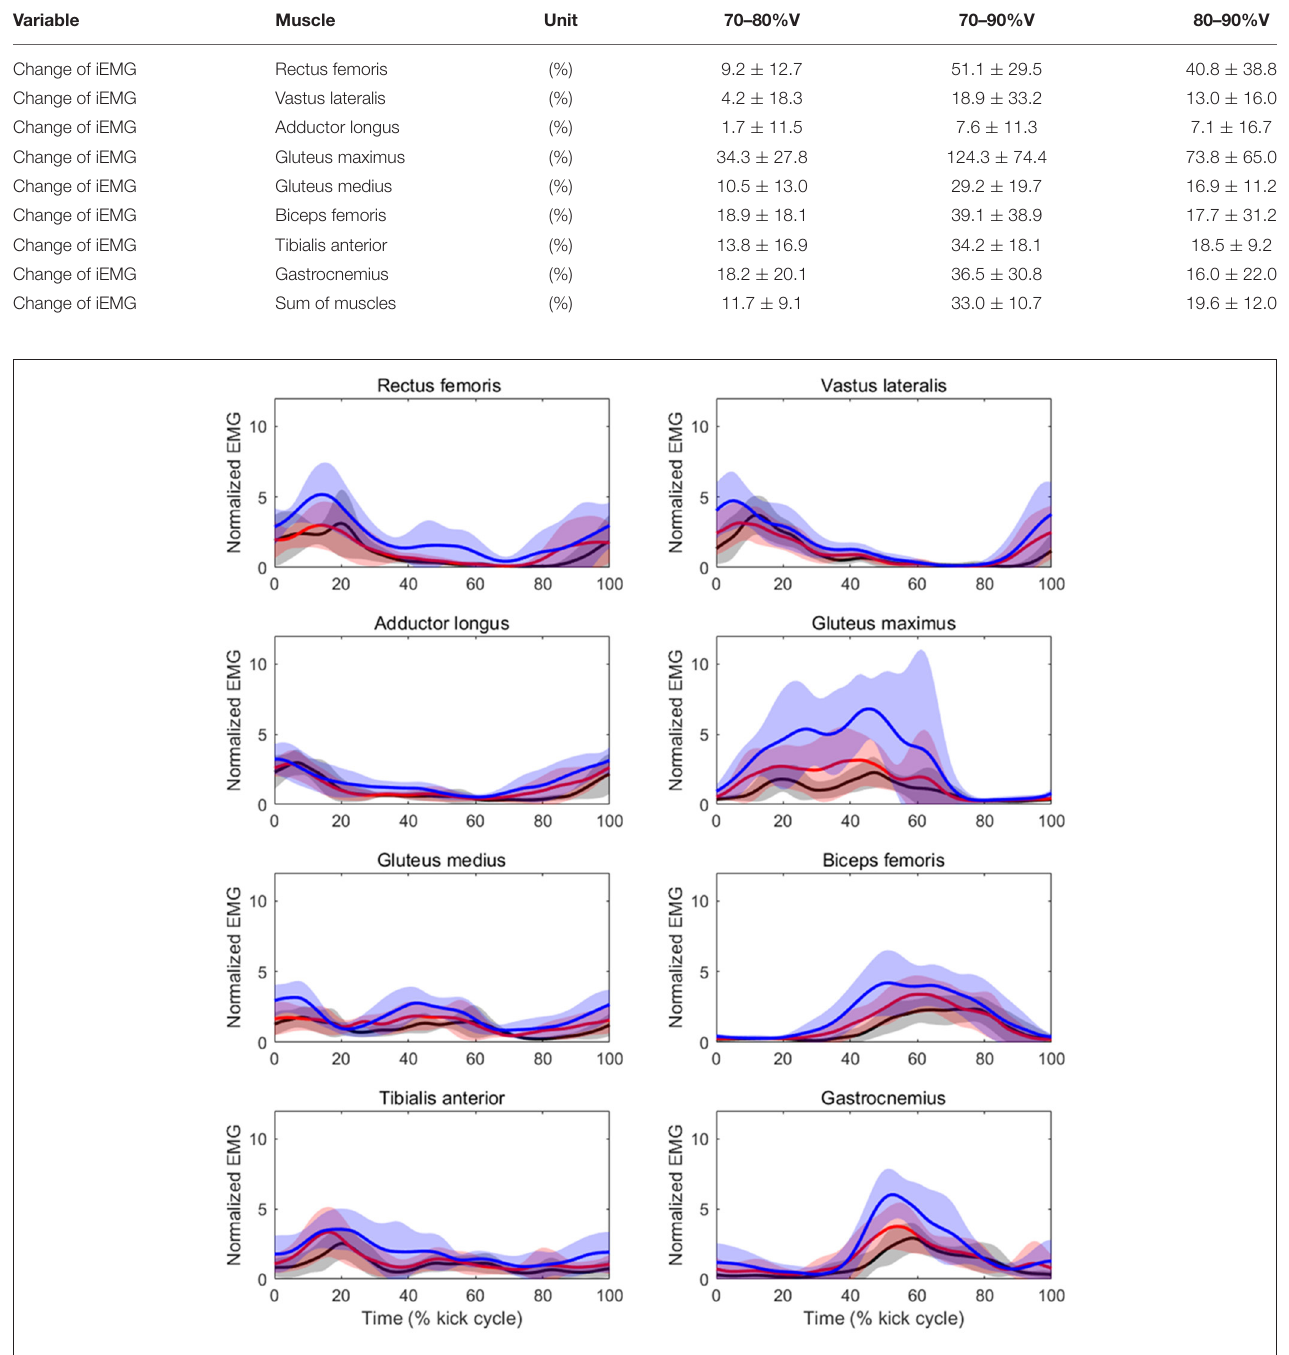
FIGURE 5 | Mean patterns and standard deviations for the EMG envelopes normalized to the mean of the 70%V trial at 70%V (black) and 80%V